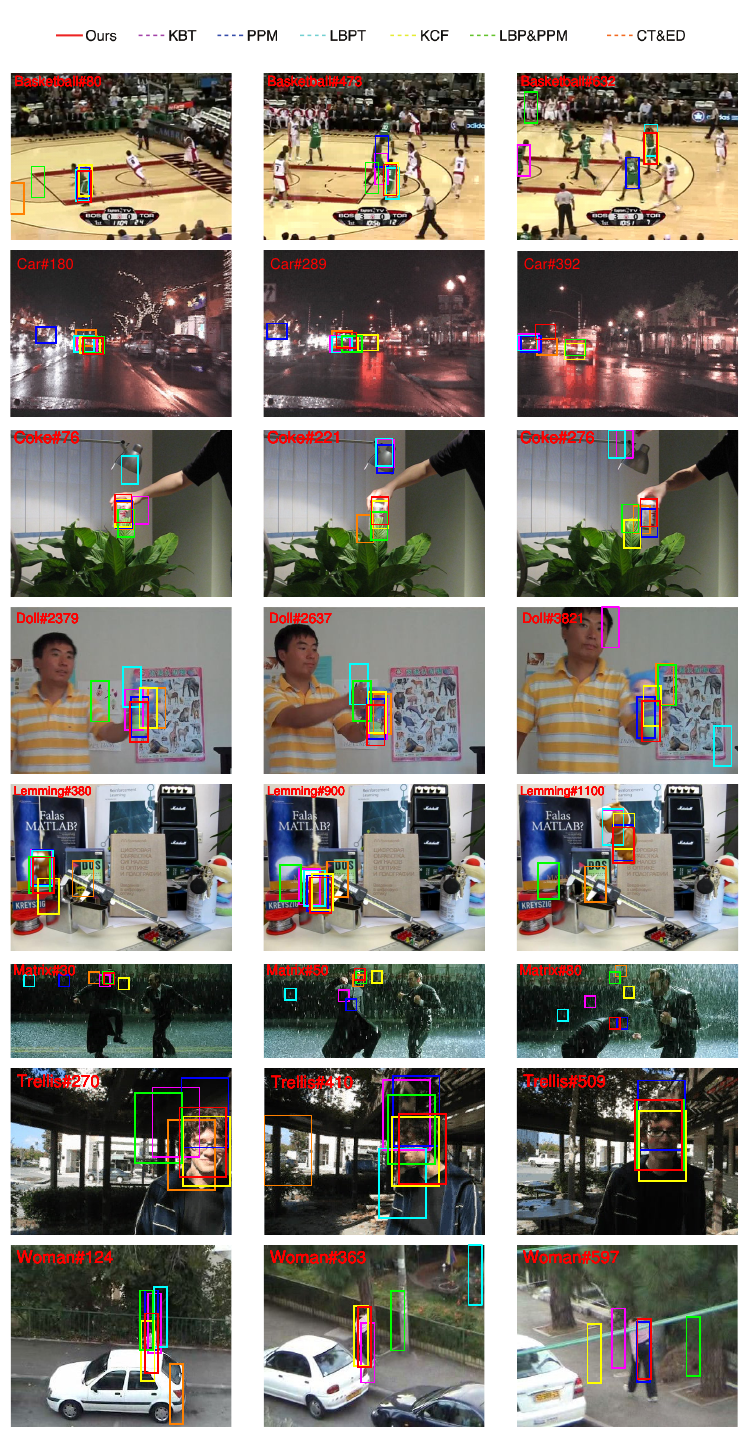
Figure 8. Experiment results of our proposed algorithm, KBT [10], PPM [15], LBPT [20], KCF [9], LBP&PPM and CT&ED on eight challenging sequences (from top to bottom are Basketball, Car, Coke, Doll, Lemming, Matrix, Trellis, Woman,